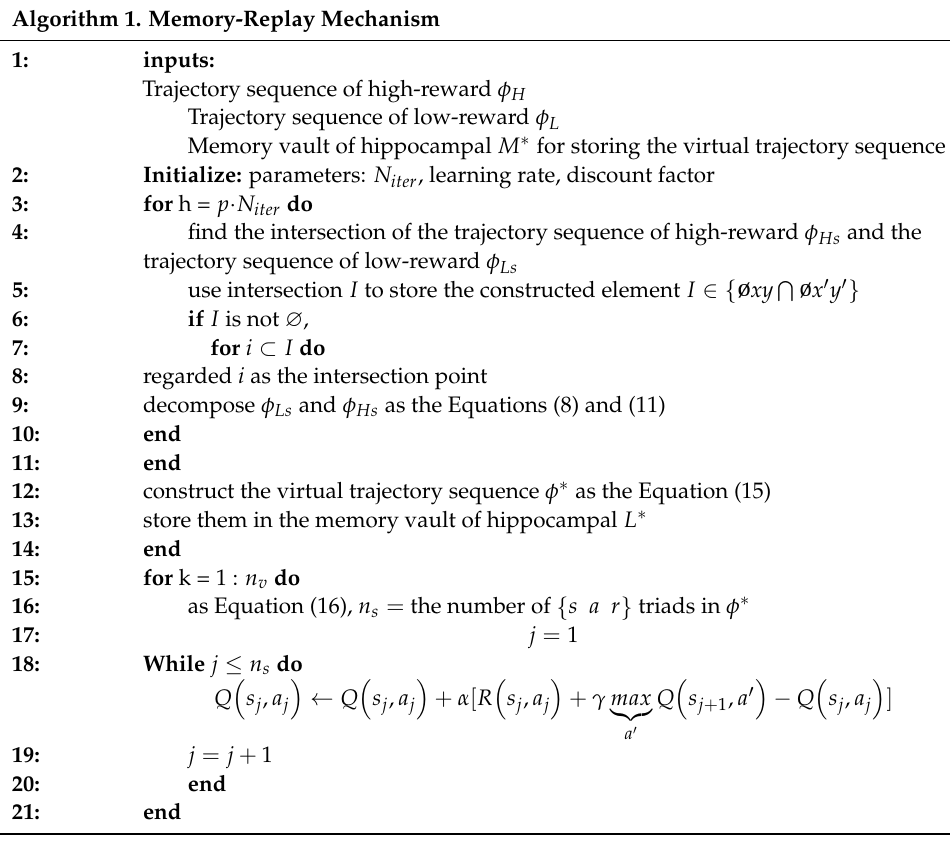
Algorithm 1. The Memory-Replay Mechanism. Algorithm 1. Memory-Replay